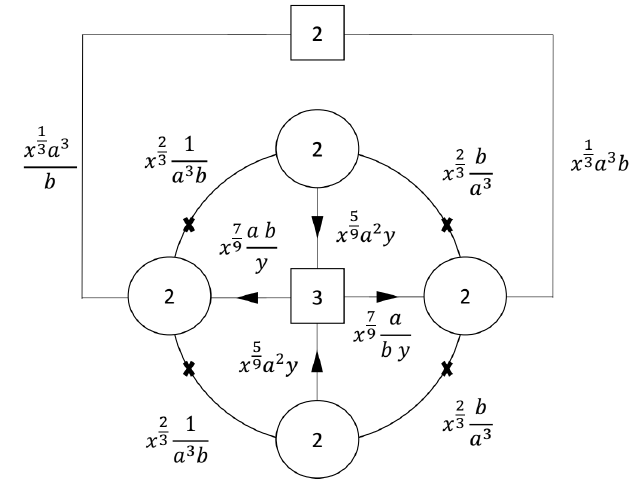
Figure 9 . The 3 d quiver theory associated with the compactification of the 5 d E 6 SCFT on a √ torus with flux ( 3; 1 , 1 , 1 , 0 , 0) . There are Chern-Simons terms of levels ( 1 also contains cubic superpotential interactions associated with the four triangles, and the flipping superpotentials. Additionally, there are two quartic superpotential involving the bifundamentals charged under the global SU(2) group with the upper and lower semi-circles, and four monopole superpotential of the type (1 , 1) for all adjacent SU(2) groups, properly dressed by SU(2) × SU(2) bifundamentals to form a gauge